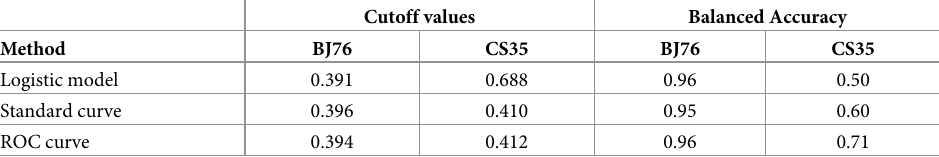
Table 1. Cutoff values calculated by the different methods are given for each antibody. Balanced accuracy (the average of sensitivity and specificity) is given for the cutoffs in each